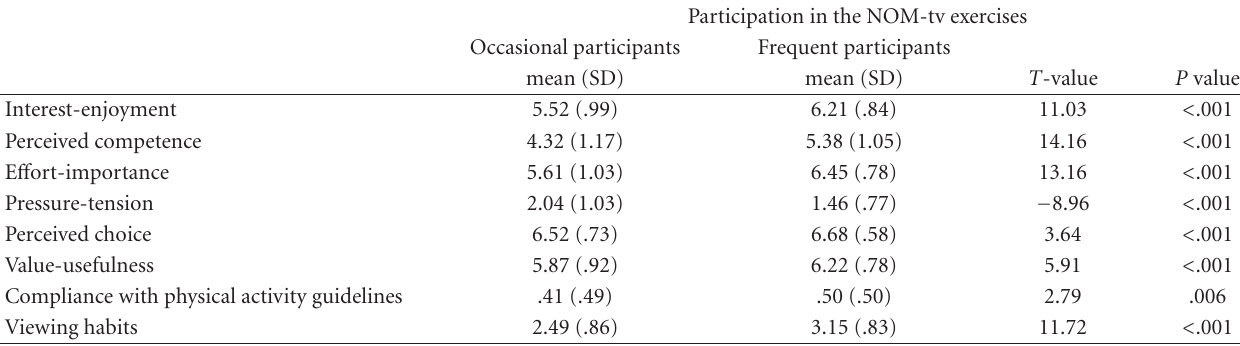
Table 3: T -test between the six IMI subscales, compliance with the physical activity guidelines, viewing habits and participation in the NOM-tv